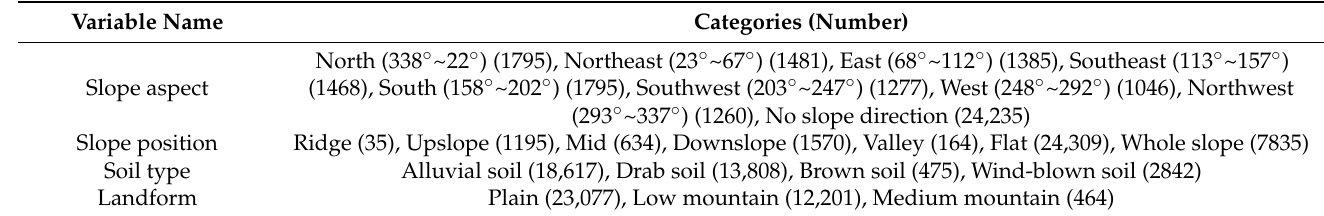
Table 3. Classification criteria and quantity for each